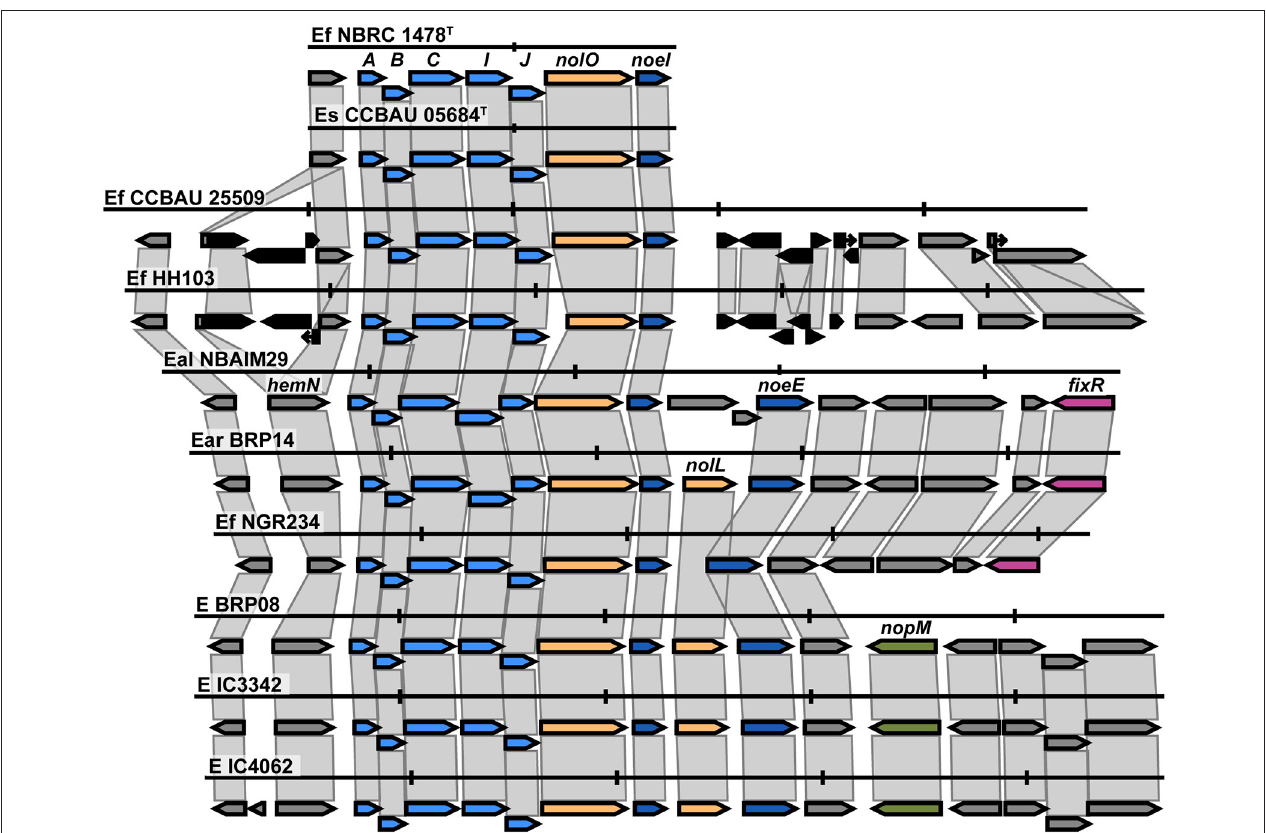
FIGURE 6 | The nod cluster synteny of IU and IC strains in the Ensifer group together with type strains. Each row represents a single strain and shows the nod cluster organisation and its genomic context. The colour of the arrow reflects the genes: blue for the nod , yellow for nol , pink for fix-nif , and black for transposase/insertion-related genes. Vertical markers indicate 5Kb in each genome. E ( Ensifer sp.), Ef ( E. fredii ), Es ( E. sojae ), Eal ( E. alkalisoli ) and Ear ( E. aridi ). clusters shared among By, Bc, Be, and Bi ( Figure 8C ).